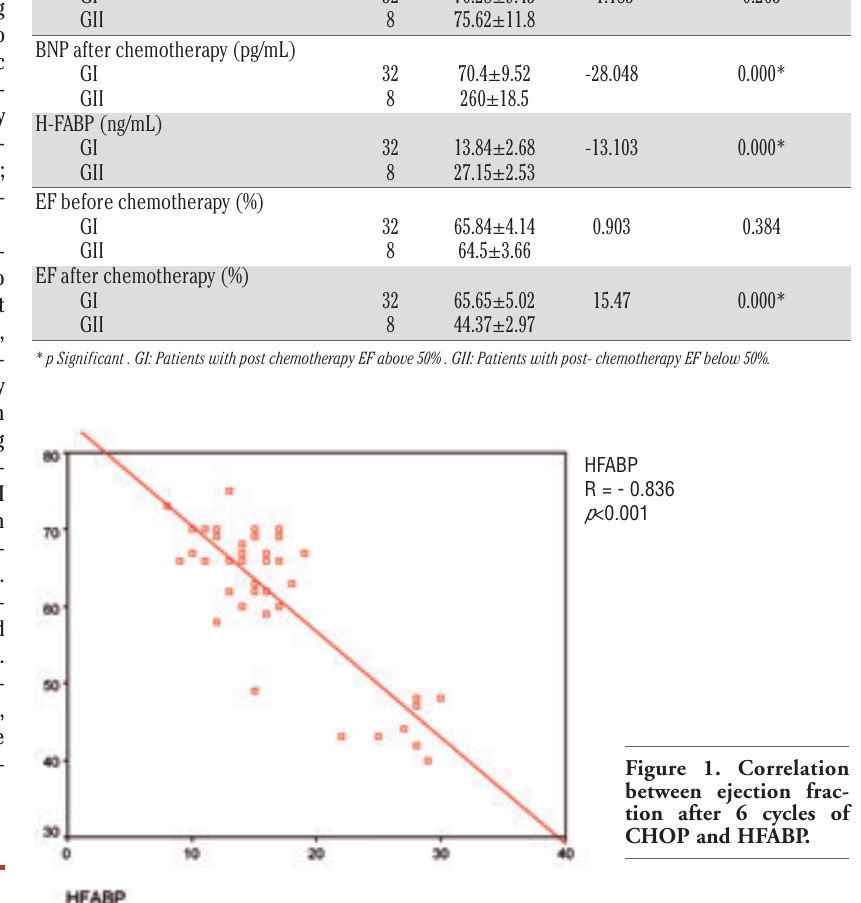
Figure 1. Correlation between ejection frac- tion after 6 cycles of CHOP and HFABP.